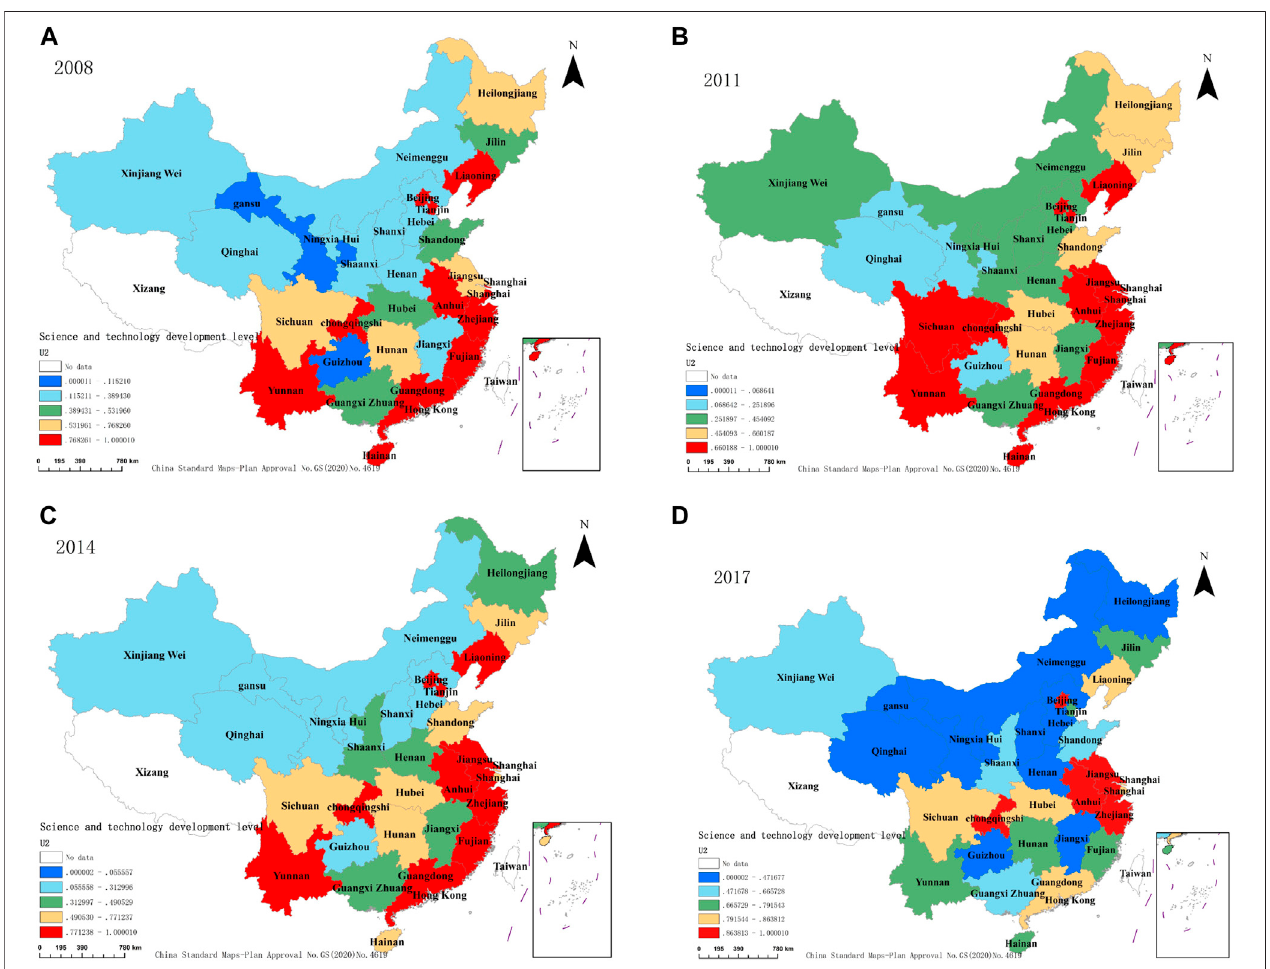
FIGURE 2 | Spatial distribution of the STDL index. (A) China ’ s provincial STDL in 2008; (B) China ’ s provincial STDL in 2011; (C) China ’ s provincial STDL in 2014; (D) China ’ s provincial STDL in 2017.